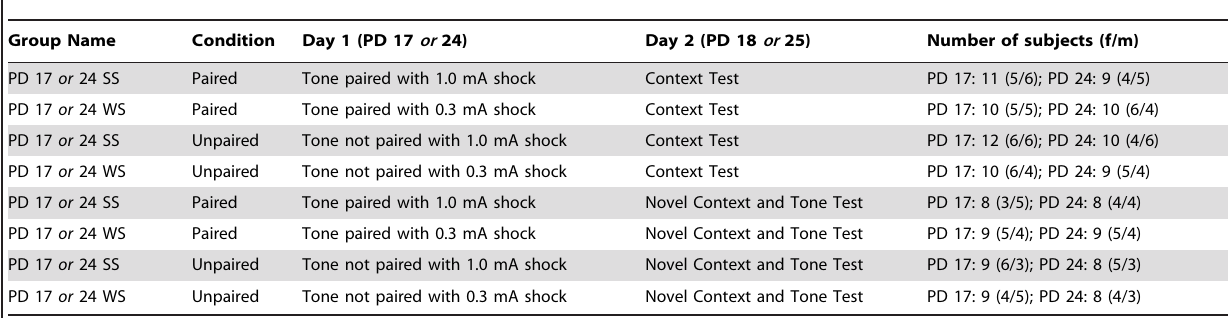
Table 2. Experimental groups and design for Experiment 2.